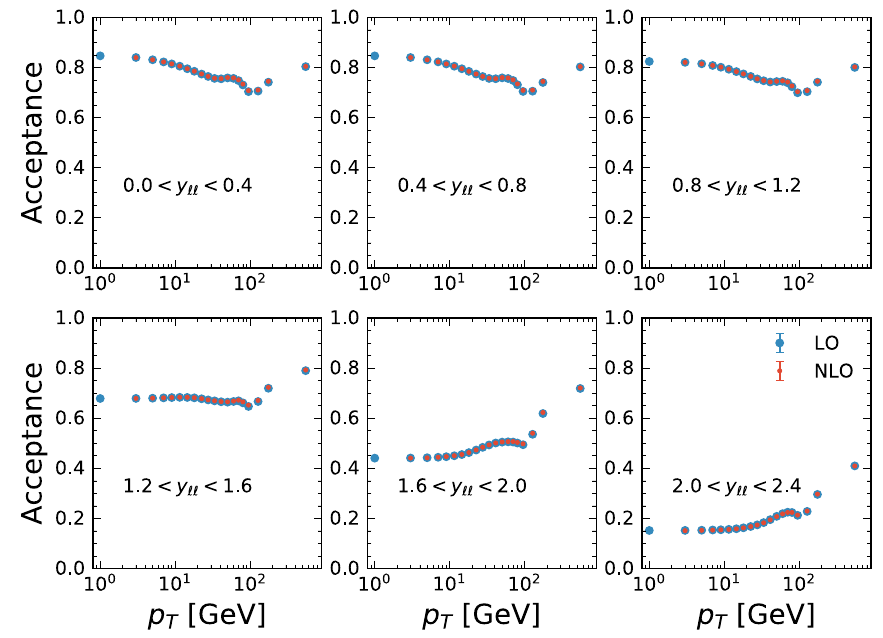
Fig. 1 Fiducial acceptance calculated at LO ( O (α S ) ) and ) ) using Z -boson NLO ( O (α 2 S plus jet process. The error bars show total uncertainties of the